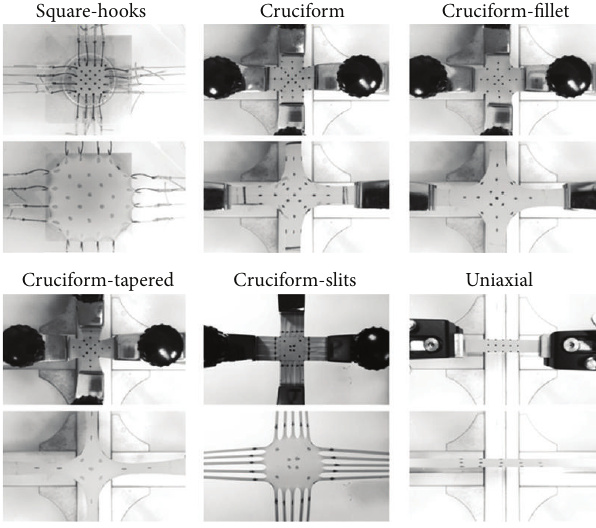
Figure 4: Undeformed and deformed specimens.